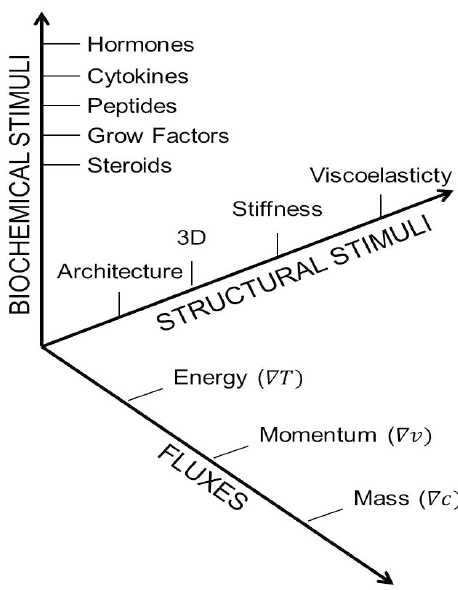
Figure 2. The three axes of stimuli which act on cells in the body (adapted from [10]). The stimuli act on cells, tissues, organs and organisms, as time moves inexorably